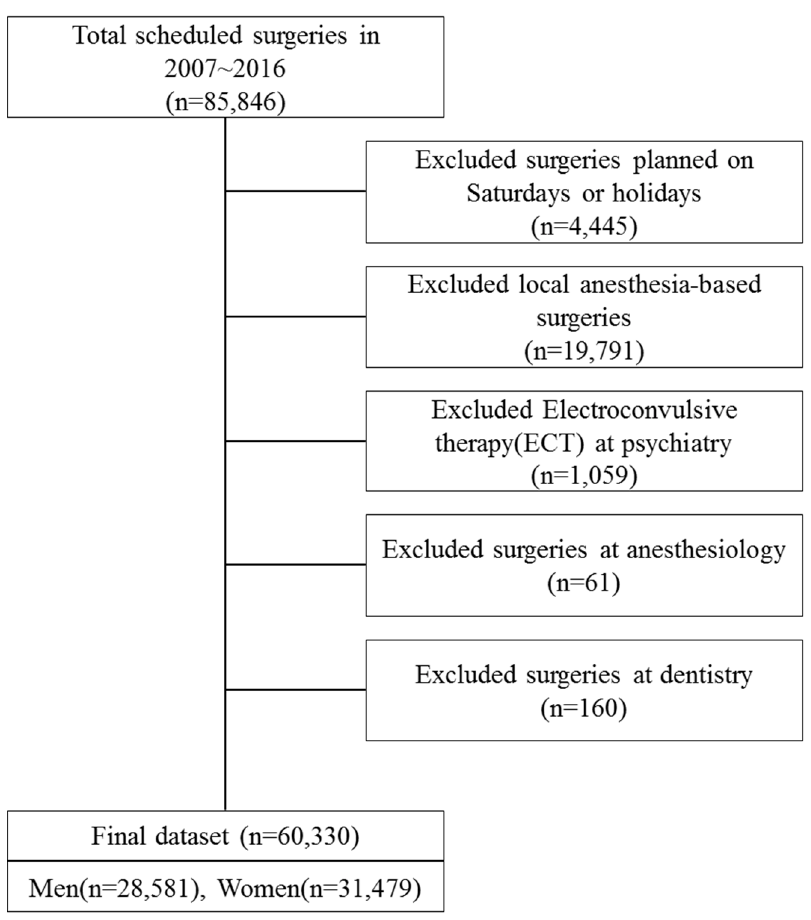
Figure 1. Flowchart for selecting participants.